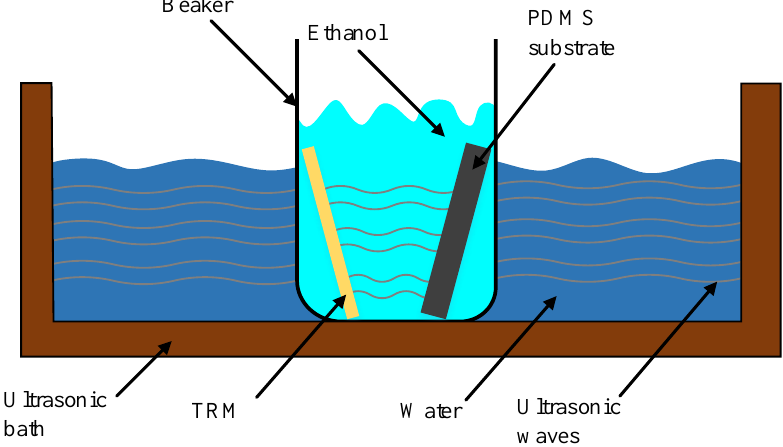
Figure 6. Cleaning setup of the TRM and the PDMS